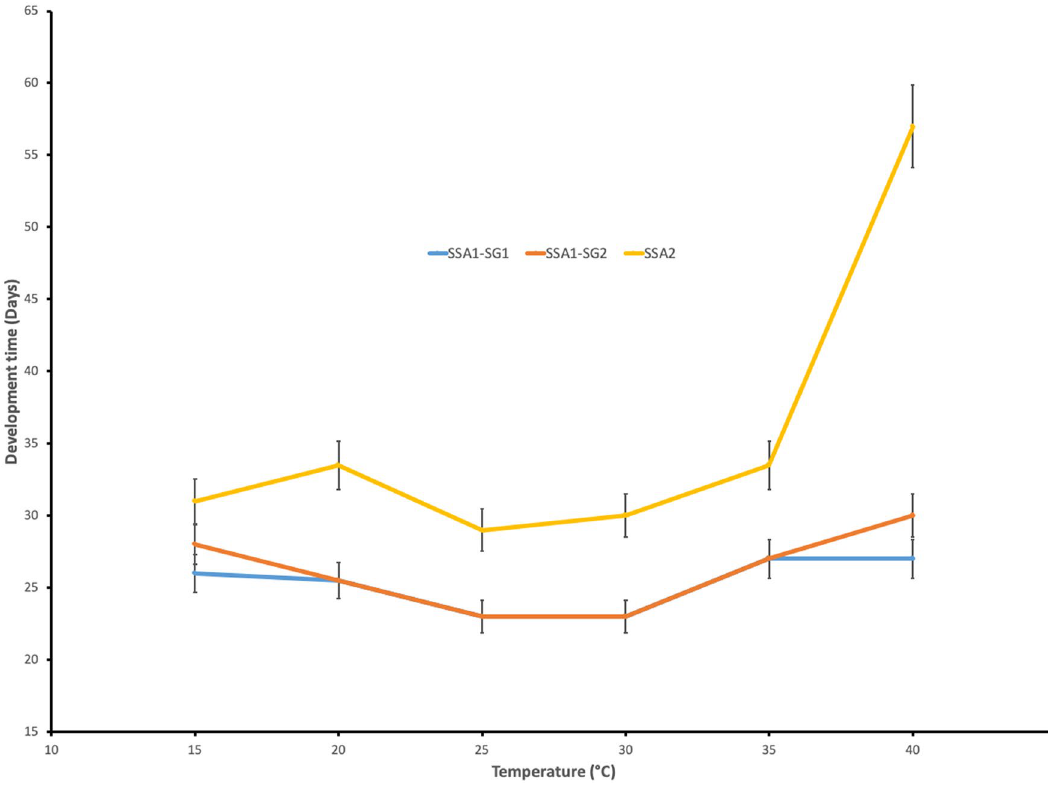
Figure 3. Mean time to develop (± SE) from egg to adult as a function of temperature for each of three Bemisia tabaci SSA isofemale lines originally collected in Uganda in 2013 or 2016. Taxonomy follows Legg et al. 28